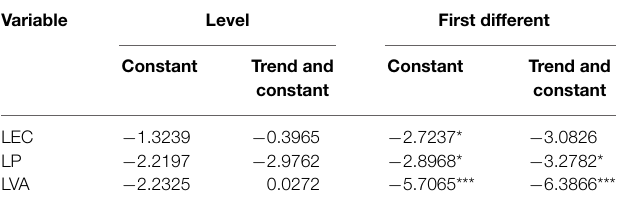
TABLE 1 | Phillips–Perron unit root test .